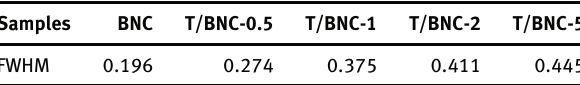
Table  : Full width at half maximum (FWHM) of (  ) plane of Bi  NbO  Cl in the pristine BNC and T/BNC-x. Samples